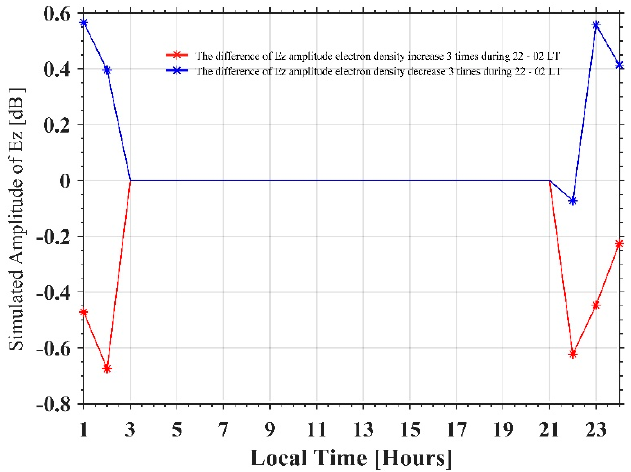
Figure 12. The red solid line with asterisks represents the difference in Ez amplitude between the electron density (from 100 km to F2 region) set thrice and the original IRI profile. The blue solid line with asterisks represents the difference in Ez amplitude when electron density (from 100 km to F2 region) is set as 1/3 times and the original IRI profile.